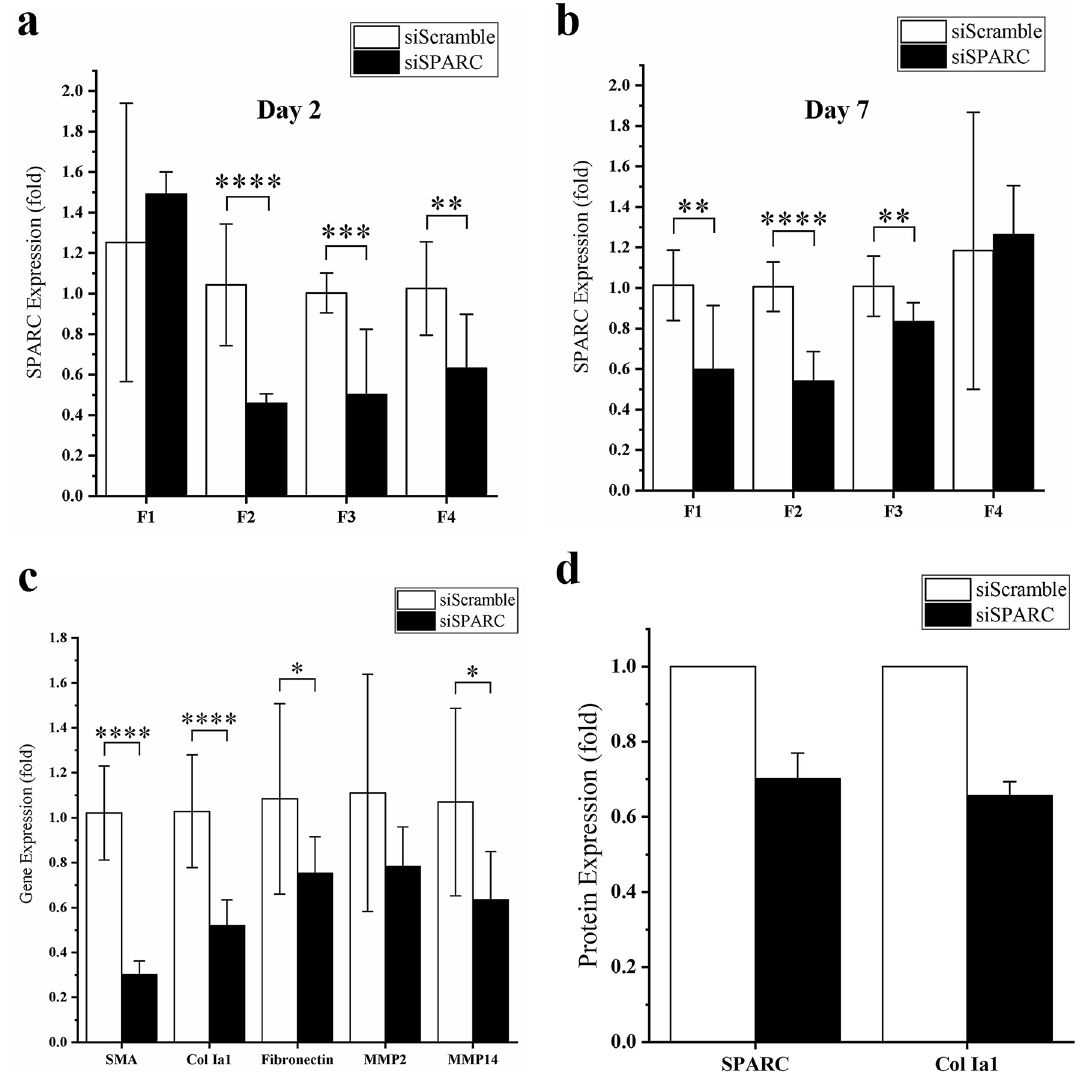
Figure 3. SPARC expression of C57Bl6/J MTFs at day (a) 2 and ( b ) 7 when treated with siSPARC-loaded Gtn-Tyr hydrogel with different surface charges. ( c ) Gene expression of SMA, Col 1a1, fibronectin, MMP2 and MMP4; and ( d ) SPARC and Col 1a1 protein expression of C57 MTFs after being treated with optimal hydrogel formulation (F2) at day 7. * denote P < 0.05, ** denote P < 0.01, *** denote P < 0.001 and **** denote P < shown), and blebs were no longer visible at 4 weeks (Fig. 5a). Similarly, siScramble-hydrogel treatment failed to maintain bleb survival at 4 weeks (Fig. 5b). In marked contrast, a shallow but still visible bleb can still be observed upon treatment with siSPARC-hydrogel for at least 4 weeks (Fig. 5c). When the week 4 postoperative tissues were examined by in vivo confocal microscopy, it can be observed that MMC treatment had grossly loosened the subconjunctival matrix with numerous microcysts retained in the failed bleb (Fig. 5d). This morphology contrasted with the densely organized matrix fibers and the lack of microcysts in the subconjunctiva treated with siScramble-hydrogel (Fig. 5e). On the other hand, treatment with siSPARC-hydrogel resulted in an ostensibly perturbed matrix fiber organization and the presence of numer- ous microcysts reminiscent of MMC treatment, albeit to a lesser extent (Fig. 5f). Moreover, siSPARC-hydrogel treatment was associated with mainly straight vasculature, which included both large and fine vessels in the subconjunctiva (Fig. 5i). This vasculature architecture is a distinguishing feature against the mainly tortuous vessels found in both MMC and siScramble-hydrogel treated tissues (Fig. 5g,h). Finally, while hyper-reflective dots characteristic of MMC treatment were easily visible (Fig. 5j), hydrogel remnants may be visualized within the treated subconjunctivas as a cobbled stone-like network (Fig. 5k,l). Further histological examination of the treated conjunctivas provided corroborating evidence for the effective- ness of the different treatments in facilitating bleb survival. Hematoxylin and eosin (H&E), Masson Trichrome and Picro-Sirius red staining revealed that although a cleared area almost devoid of the matrix was present in the MMC-treated conjunctiva after 4 weeks (*, Fig. 6a–c), a surprisingly relatively larger portion of the tissue was, however, occupied by dense collagen fibers (ψ, Fig. 6a–c). This unusual deposition of collagen scar protein